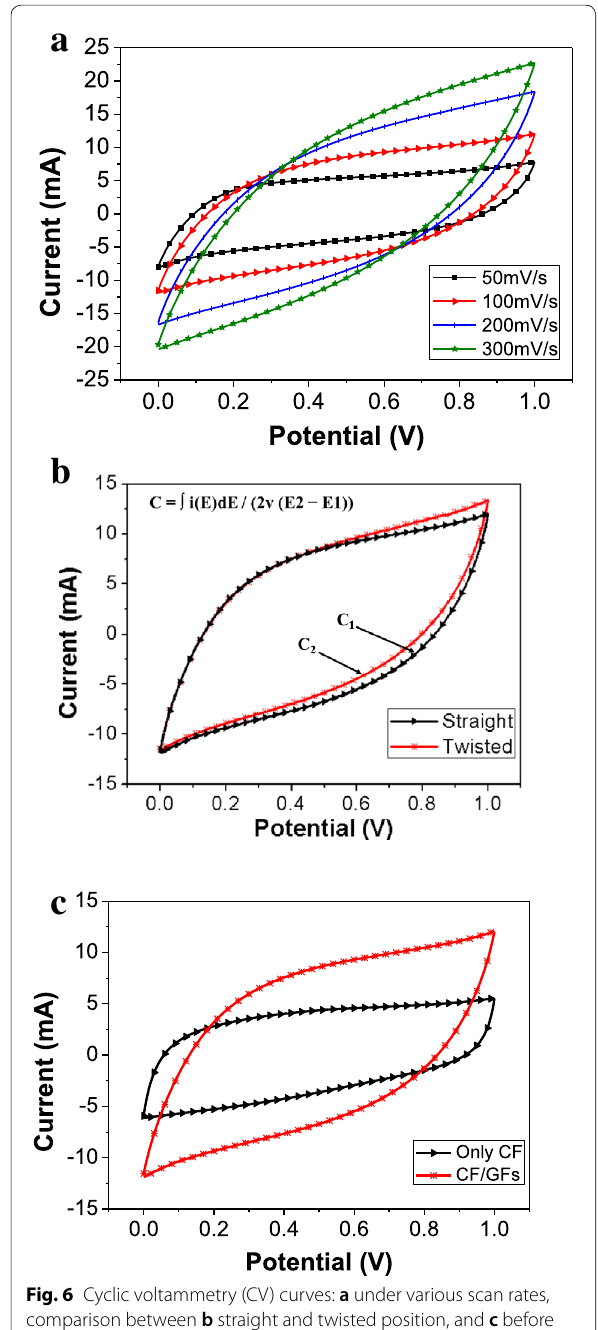
Fig. 5 Test setup for the electrochemical analysis of the fabricated supercapacitor